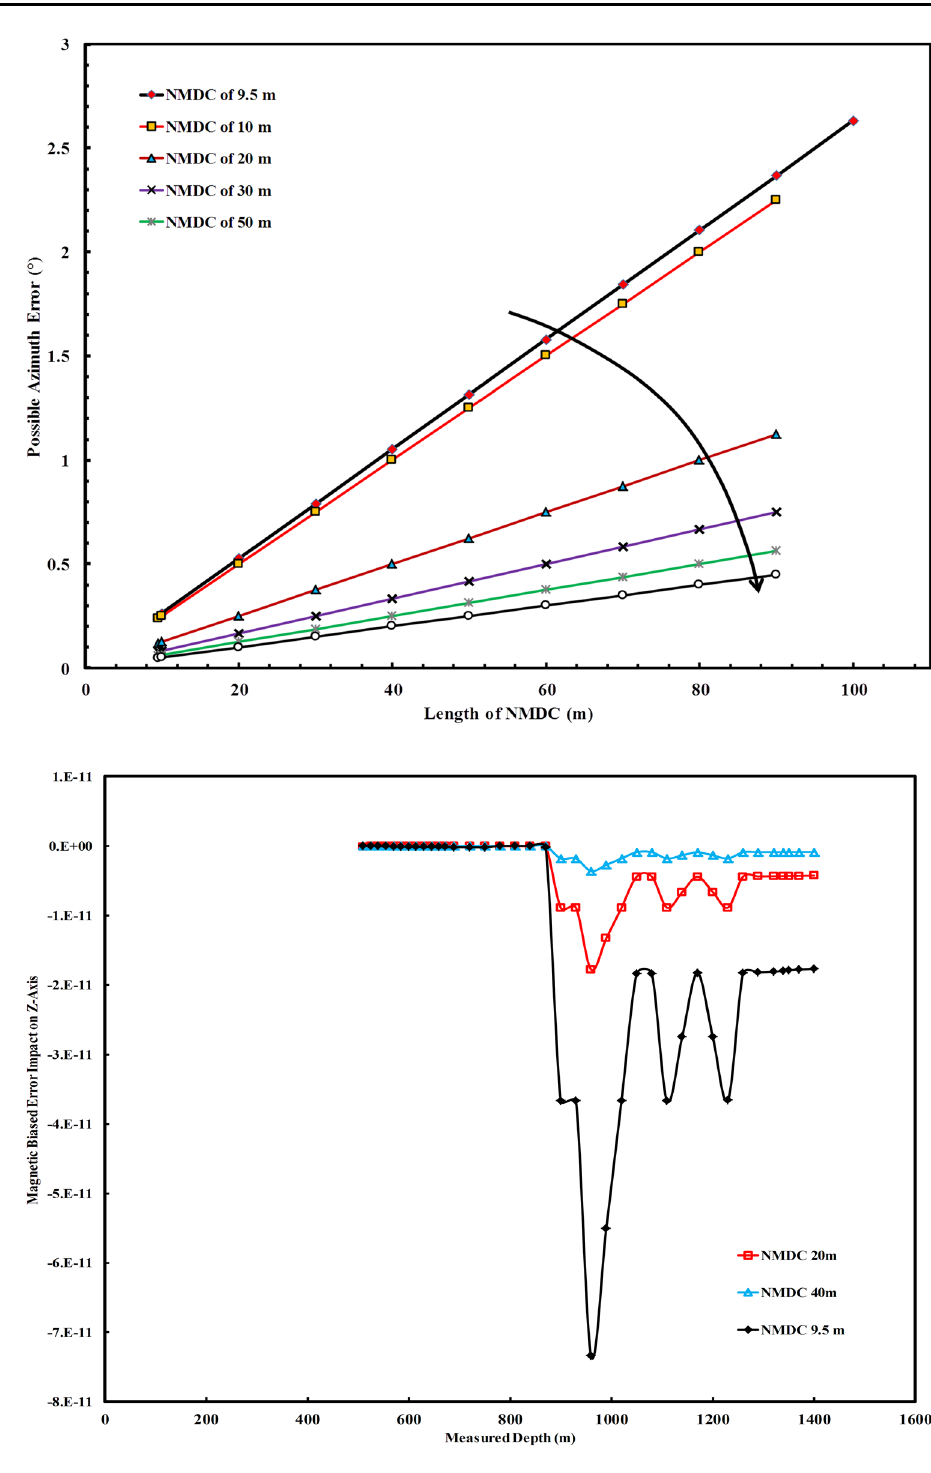
Fig. 5 Possible error in azimuth for not using the recommended length of NMDC